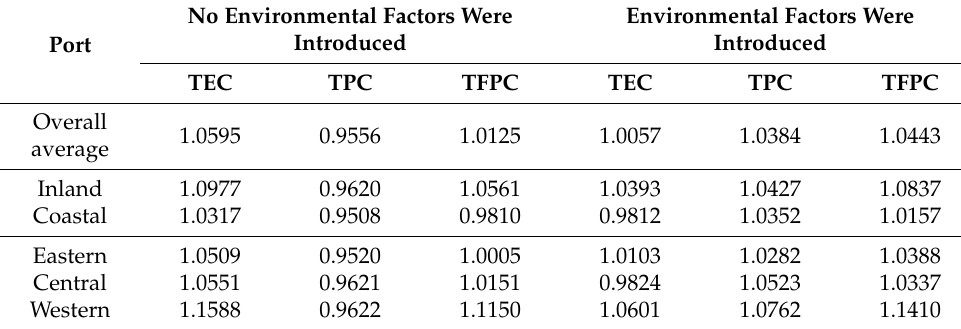
Table 5. TFP index of port type and region and its decomposition mean